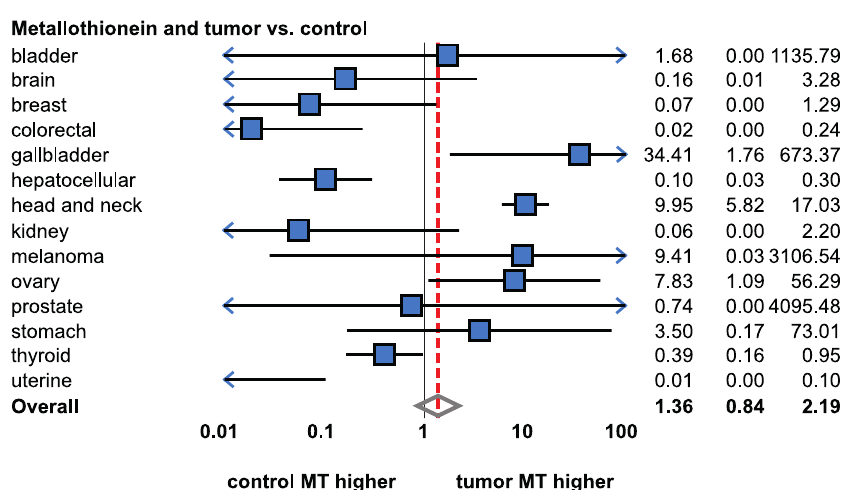
Figure 2. Forrest plot showing associations between metallothionein staining and tumors (tumors versus healthy controls). The result of meta-analysis for particular tumor types displayed instead of individual studies. For more detailed results see Table 1 and 2. Sorted alphabetically by tumor types. Forrest plot displayed as odds ratio and 95% confidence intervals. Red dashed line indicates the result for all tumor types together. OR, odds ratio; CI, confidence interval.